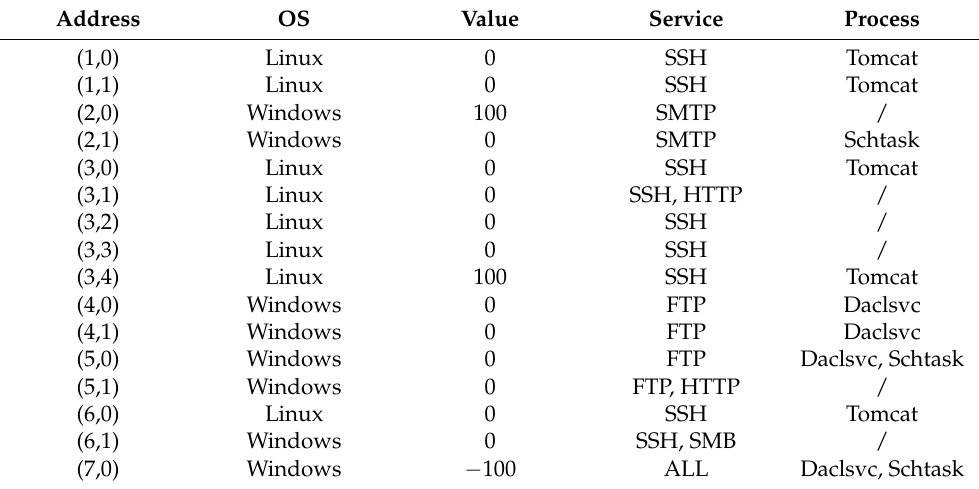
Table 1. Configurations of each host in scenario 1. Five vulnerable services, three processes, and two operating systems running in computers are chosen to configure the hosts and also define their points of vulnerabilities. Hosts with value of 0, 100, and − 100 represent the common hosts, sensitive hosts, and the honeypot host, respectively.